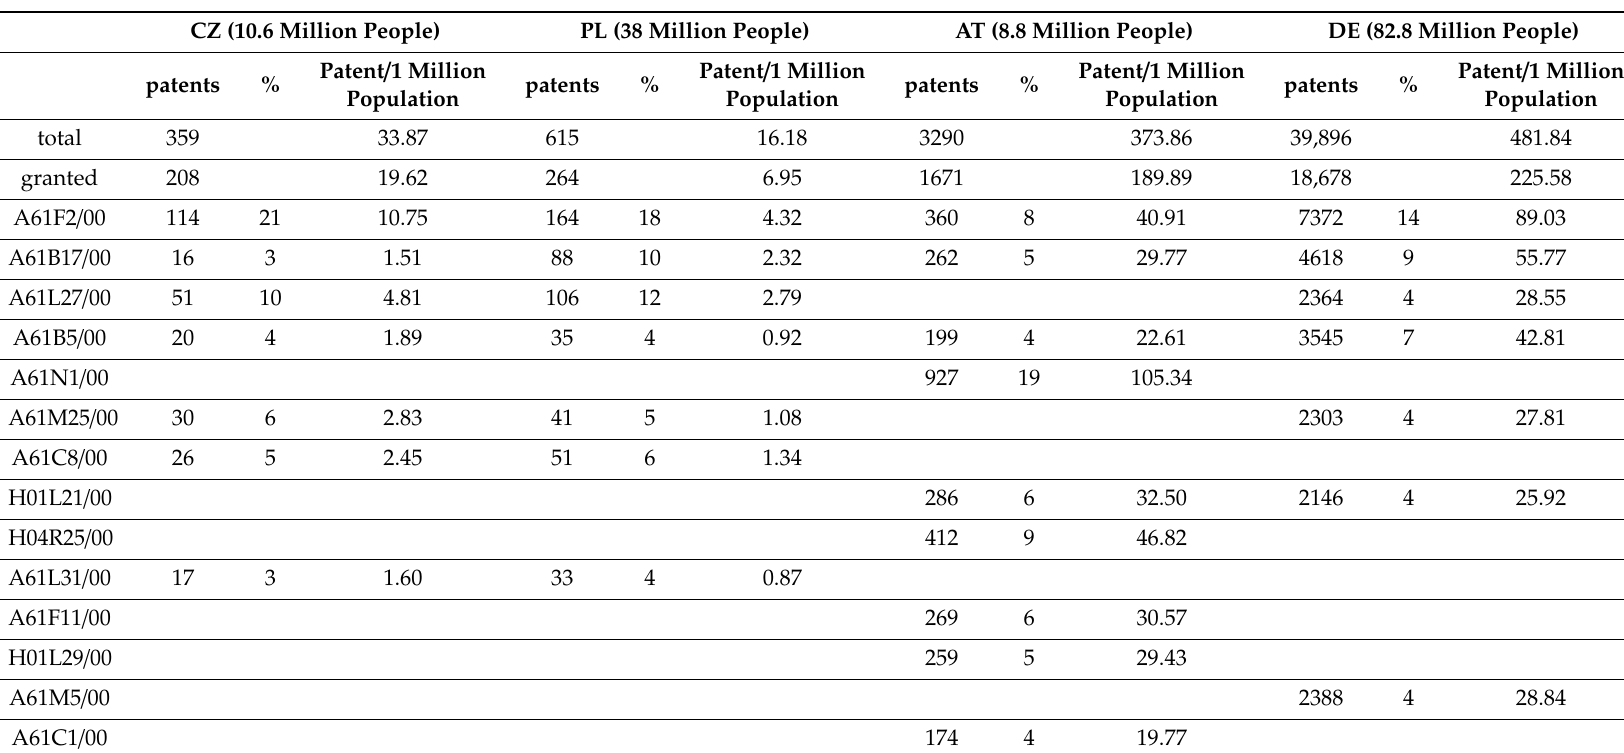
Table 2. Patents in the period 1 January 1999–2019; patents compared internationally between Western and Eastern European